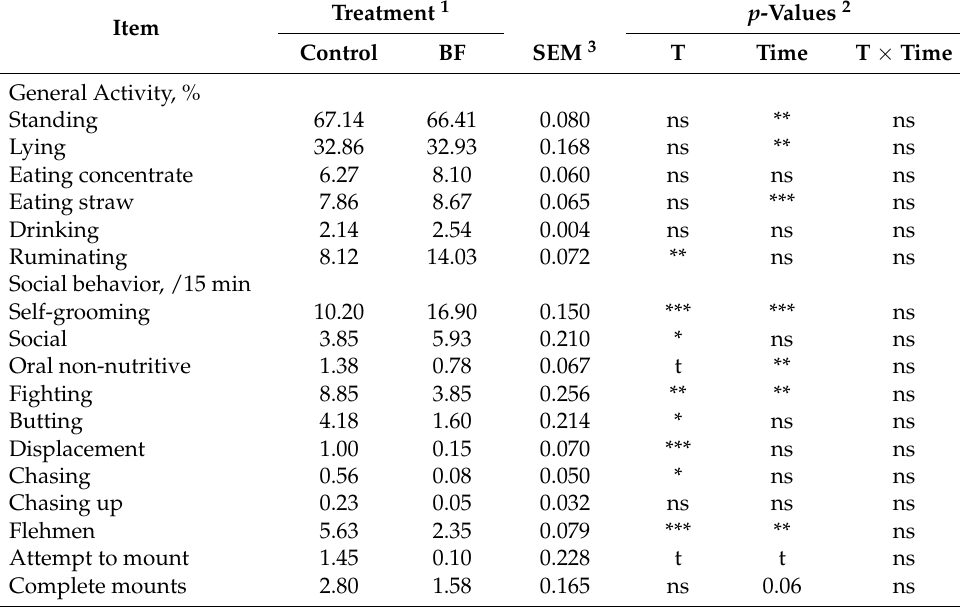
Table 4. General activities (%) and social behavior (times/15 min) for finishing phase in Holstein bulls fed high-concentrate diets supplemented with citrus flavonoids.